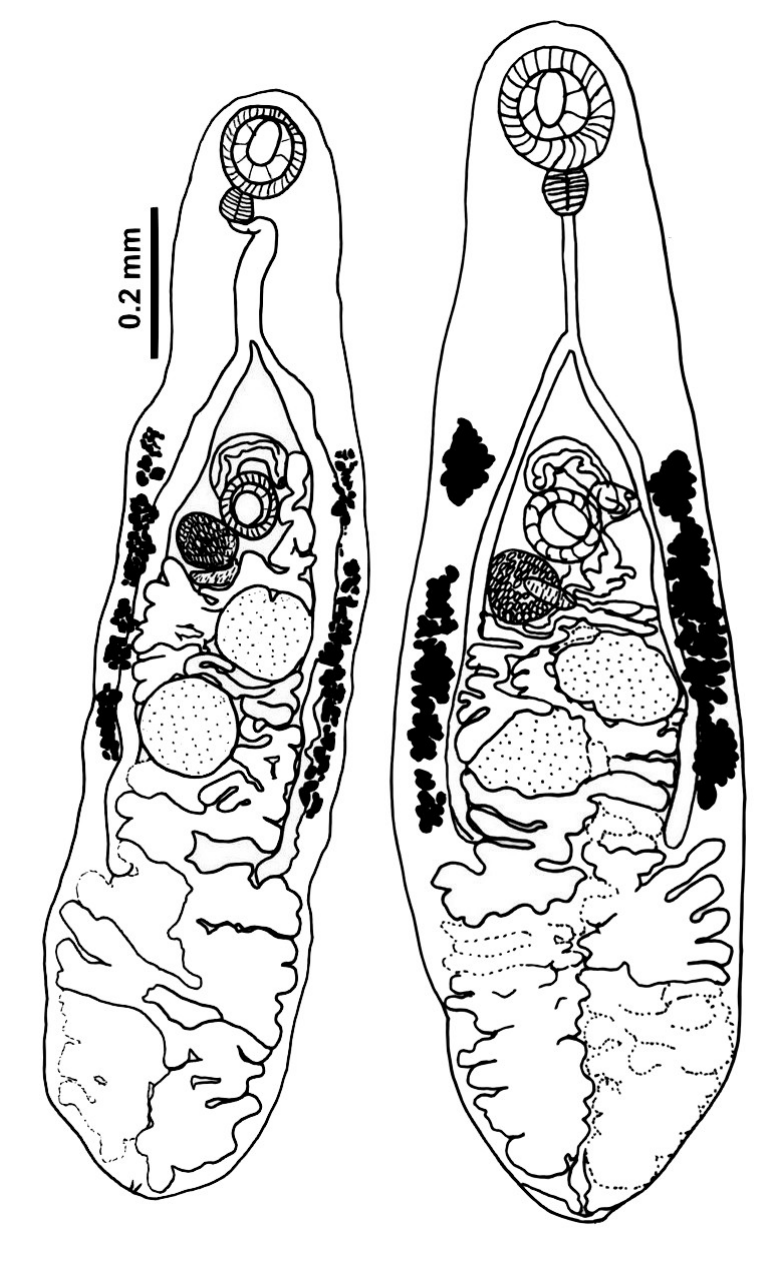
Figure 1. Haplometroides buccicola (Digenea, Plagiorchiidae) from the esophagus of Micrurus corallinus (Elapidae) (left) and Phalotris lativittatus (Colubridae)